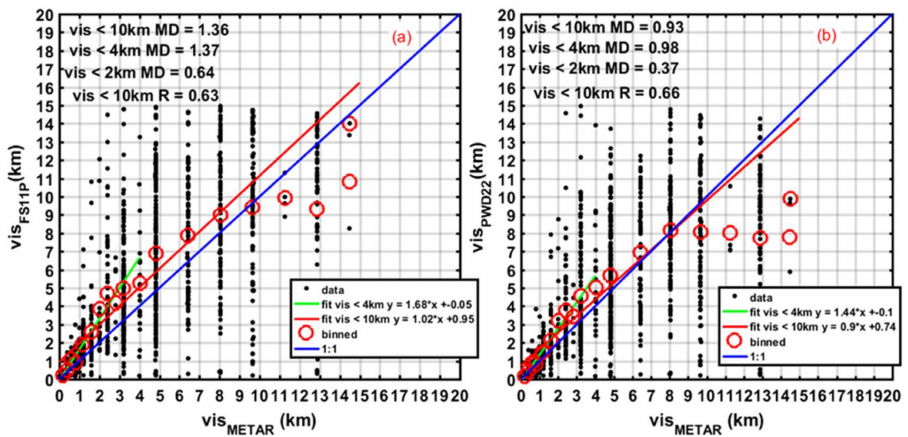
Figure 7. The measured visibility using the Vaisala FS11P ( a ) and PWD22 ( b ) plotted against human observer data (VIS METAR ). The mean difference (MD) and the best fit lines for VIS < 4 km and Vis < 10